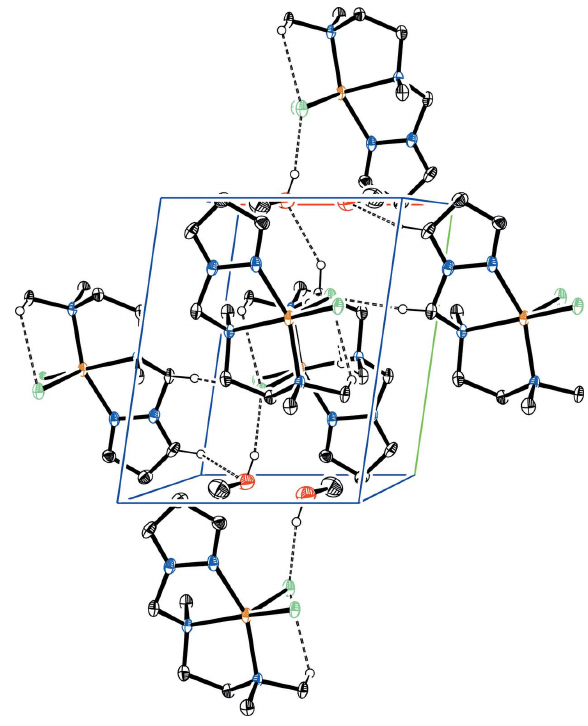
Figure 2 Part of the crystal structure showing the formation of a one-dimensional structure involving the lattice solvent and the main complex. Hydrogen bonds are shown as dashed lines.